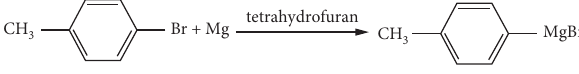
Figure 1: Flowchart of the synthesis process of Grignard